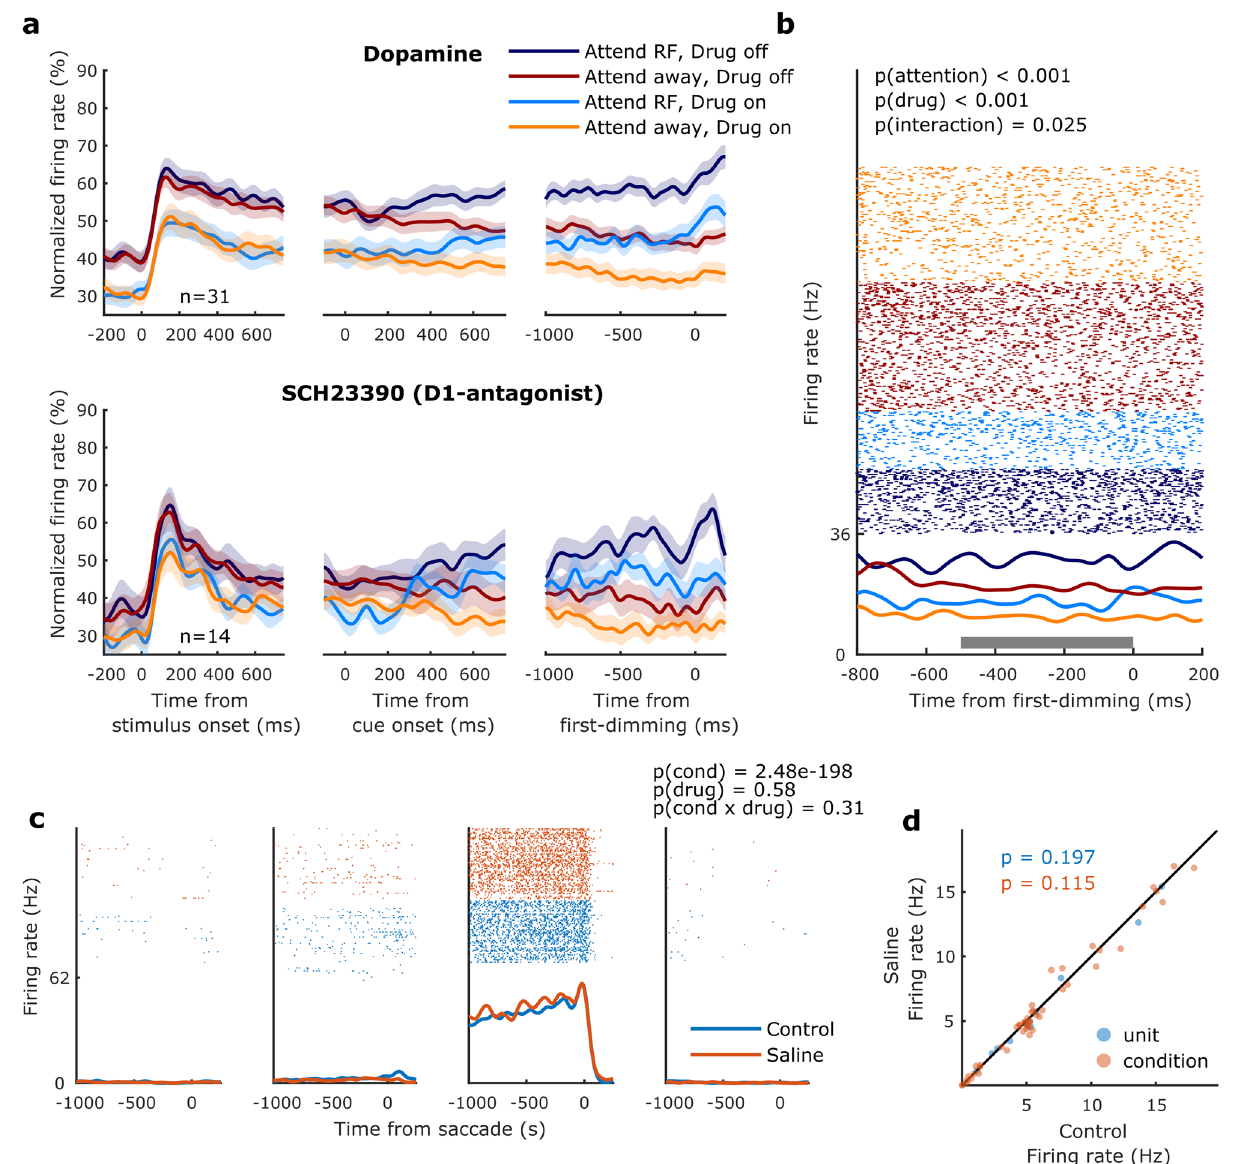
Figure 2. Population activity, example unit, and saline control. ( a ) Population histograms for all units recorded during dopaminergic drug application selective for attention and drug application. Population activity aligned to stimulus onset (left), cue onset (middle) and the first dimming event (right), for the non-specific agonist dopamine (top) and the D1R antagonist SCH23390 (bottom). Activity is normalized for each unit by its maximum activity. Error bars denote ± 1 SEM. ( b ) Activity from a cell recorded during dopamine application. This cell’s activity, aligned to the first dimming event, was significantly modulated by attention, drug application and showed a significant interaction between these factors. The grey bar indicates the time window used for statistical analyses. Statistics: two-factor ANOVA. ( c ) Activity from a representative cell recorded during application of saline (with pH matched to the dopaminergic drugs) whilst the monkey performed a memory- guided saccade task. The four panels correspond to the four quadrants in which the visual stimulus was presented. This cell’s activity, aligned to saccade onset, was significantly modulated by the spatial location of the stimulus/saccade but not by iontophoretic saline application. Statistics: two-factor ANOVA. ( d ) Average firing rates between control and saline conditions. Each marker indicates the average activity of one unit across the four conditions (blue markers) or the average activity of one unit for one of the four conditions (red markers). Statistics: two-sided Wilcoxon signed rank